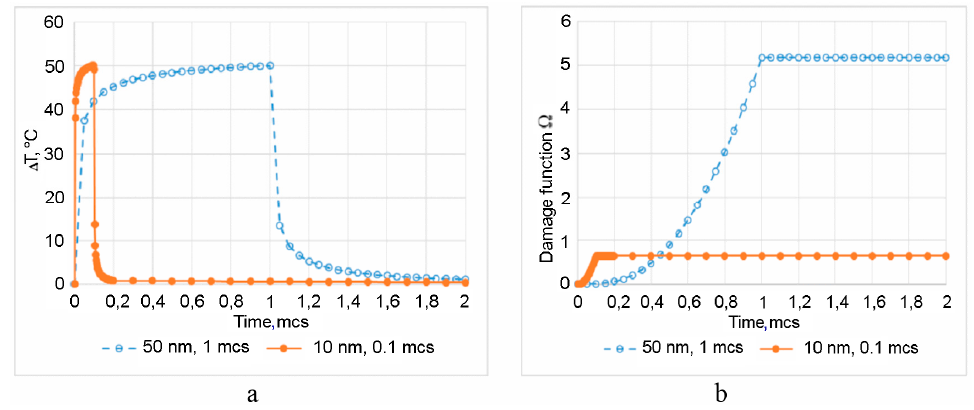
Figure 7. The temperature increments vs. time ( a ) and the Arrhenius integral Ω increments vs. time ( b ). Both curves correspond to the same laser pulse energy [52].